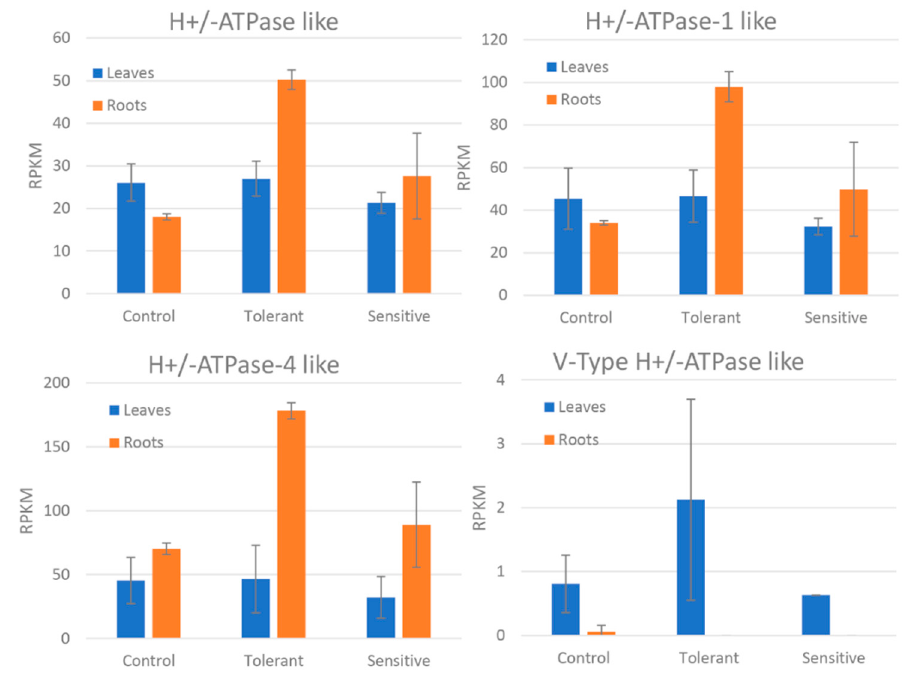
Figure 6. Reads per kilobase of transcript, per million mapped reads (RPKM) values of the di ff erentially expressed H + / ATPase-like genes between control, tolerant, and sensitive groups in leaves and roots. Bars represent standard deviation.